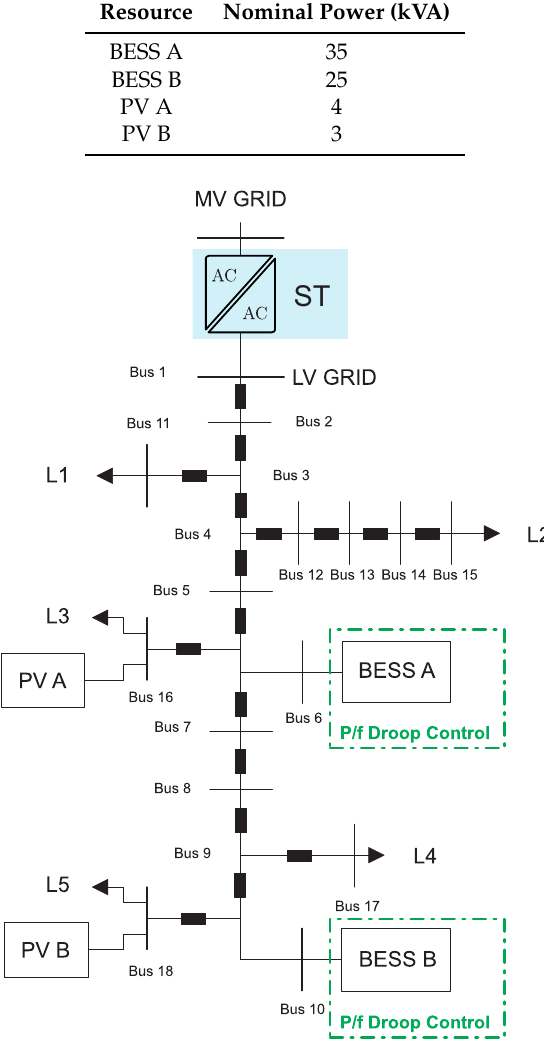
Figure 4. Grid simulated in PSCAD/EMTDC TM